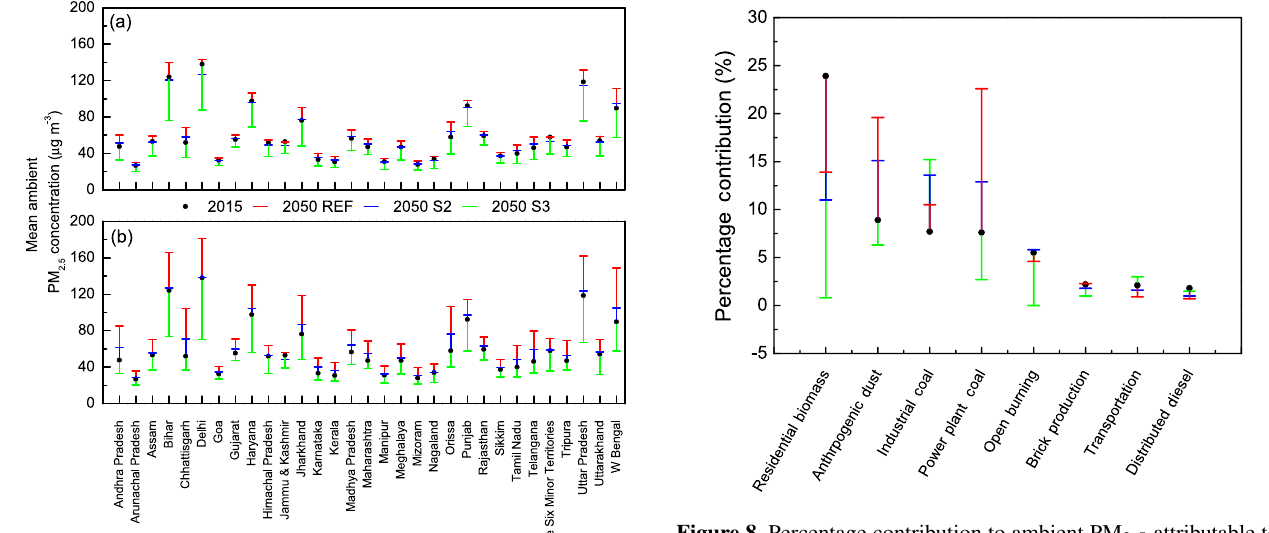
Figure 8. Percentage contribution to ambient PM 2 . 5 attributable to different sources in 2015 and 2050 for all three